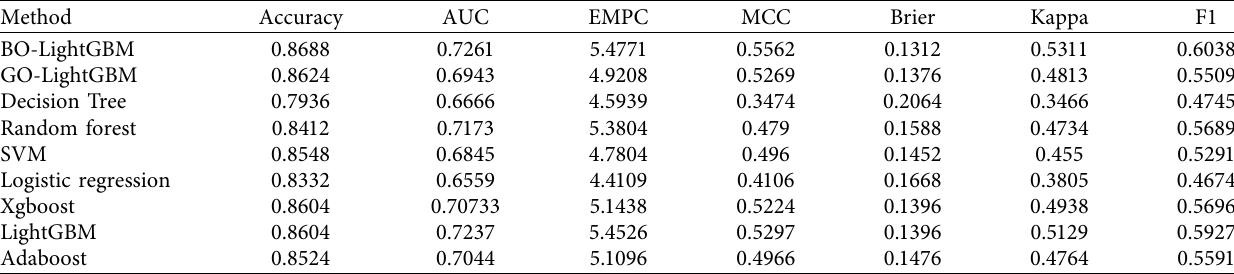
Table 10: Evaluation results in bank dataset.